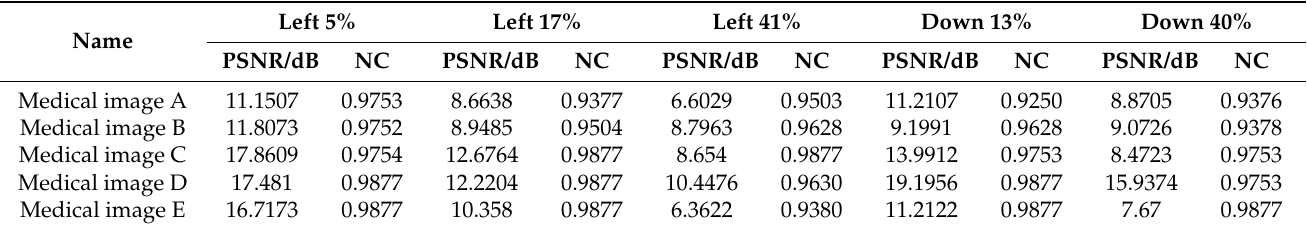
Table 7. The result under translation attacks.